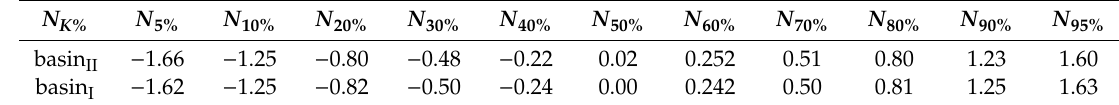
Table 5. Average experimental values of N K% coe ffi cient in the dissipation